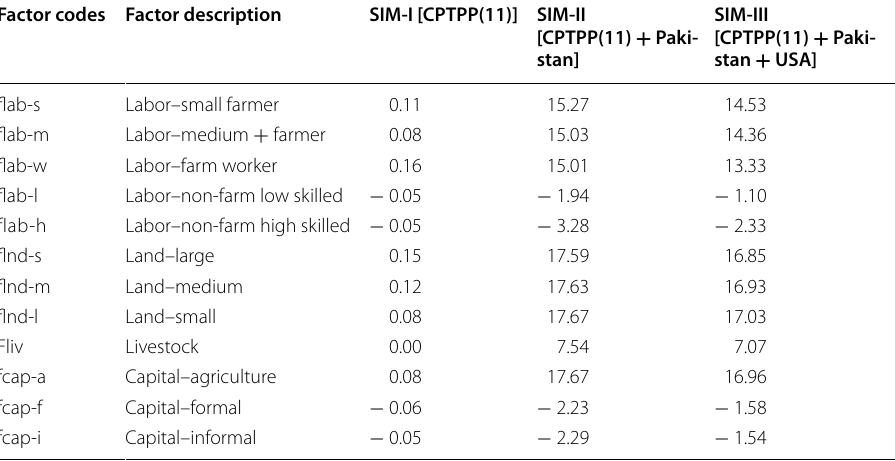
Table 8 Impact of TPP on real rewards Source : Author’s simulation Factor codes Factor